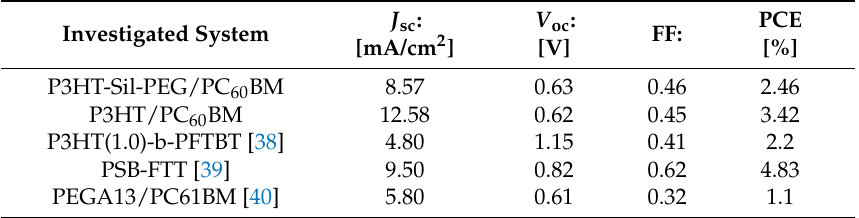
Table 4. Photovoltaic parameters of the BHJ solar cells compared with another Table4. Photovoltaic parameters of the BHJ solar cells compared with another copolymers.